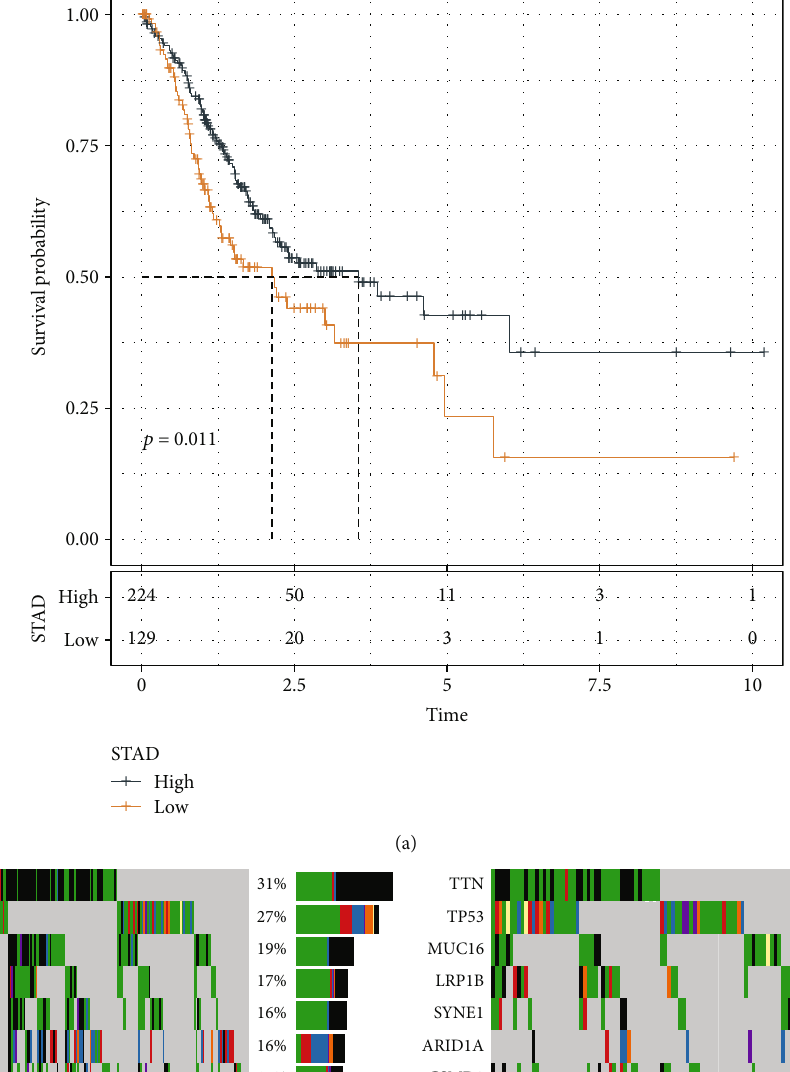
NCAPGPCLOFLGFAT4CSMD3ARID1ASYNE1LRP1BMUC16TP53TTN